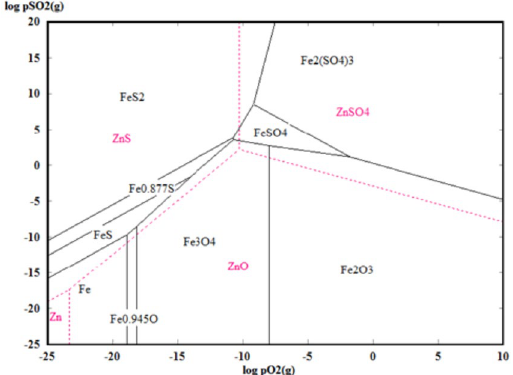
Figure 6. Predominance area diagrams of Zn-S-O and Fe-S-O system at 800